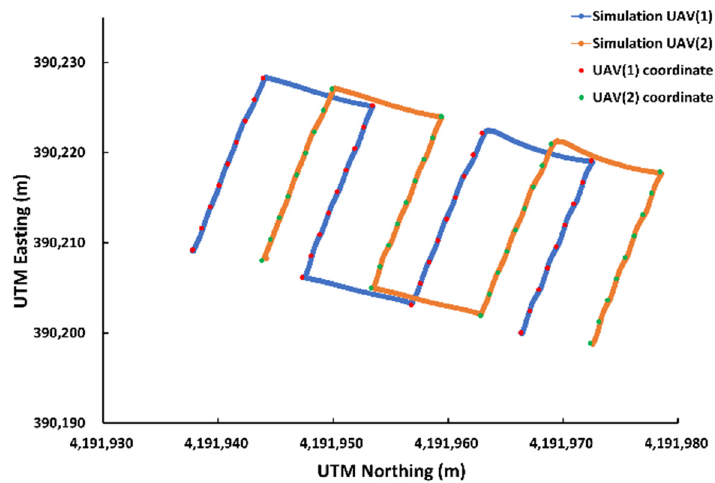
Figure 19. Flight trajectories obtained from the two UAVs in the simulation environment.